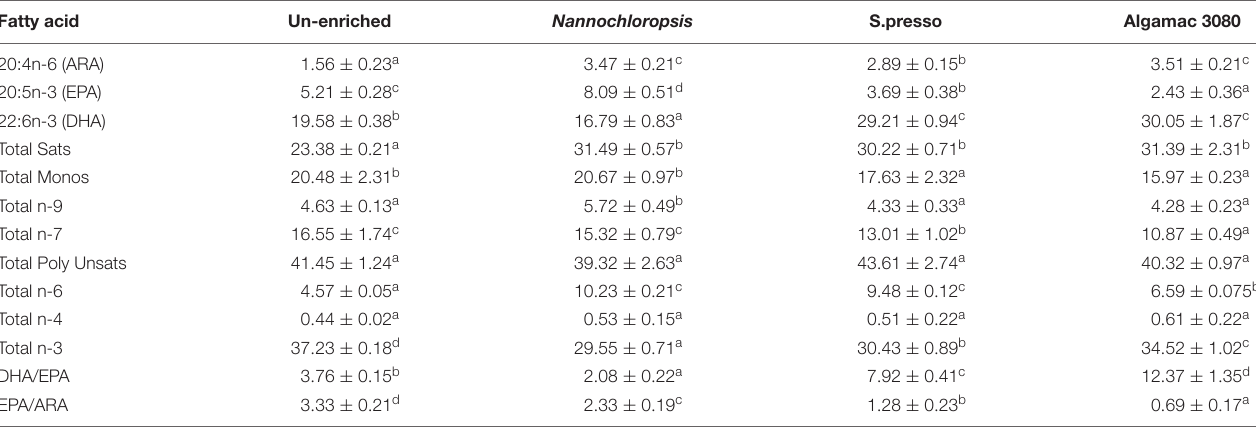
TABLE 3 | Fatty acid composition (% of total fatty acids) in 8 days post-hatching (8-DPH) fish fed enriched and un-enriched